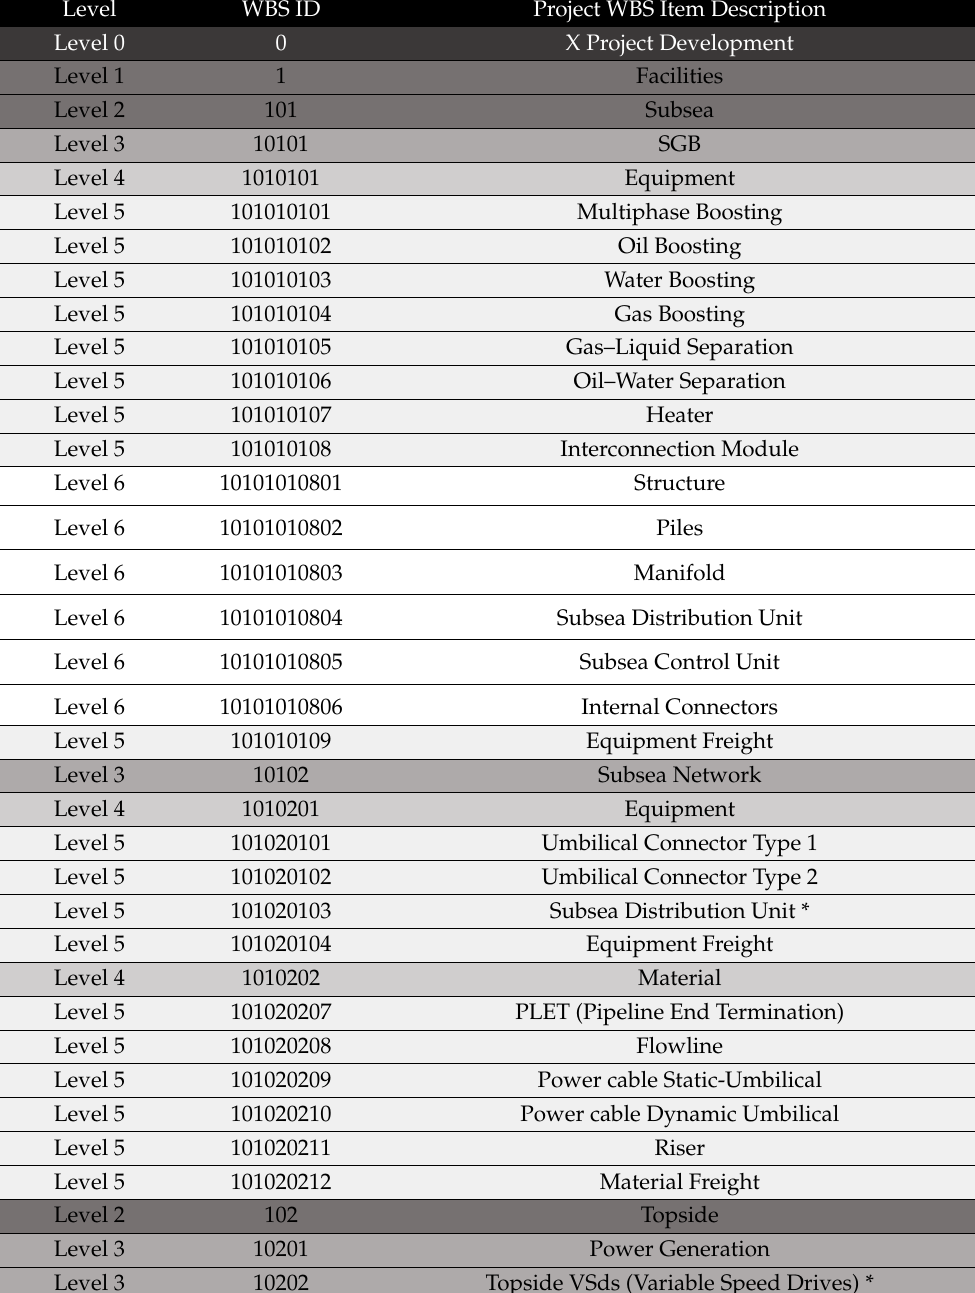
Table 3. Simplified CAPEX structure.